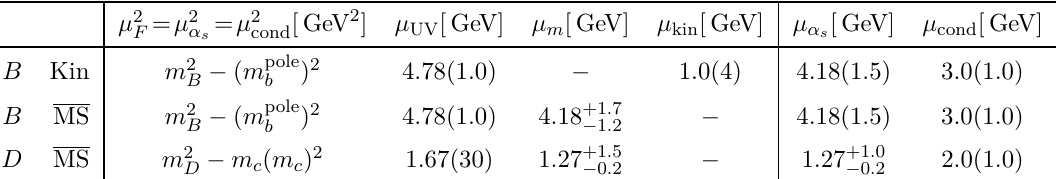
Table 1 . Summary of the scales involved in the determination of the residues (table 6) and coupling constants (table 7) to the left of the double separation line. To the right we have the scale changes used for the best determination of the decay constants (table 8). The quantity m c ( m c ) , above, is the MS mass at the scale m c . The uncertainty in µ F , for the B -meson ( D -meson), is chosen to